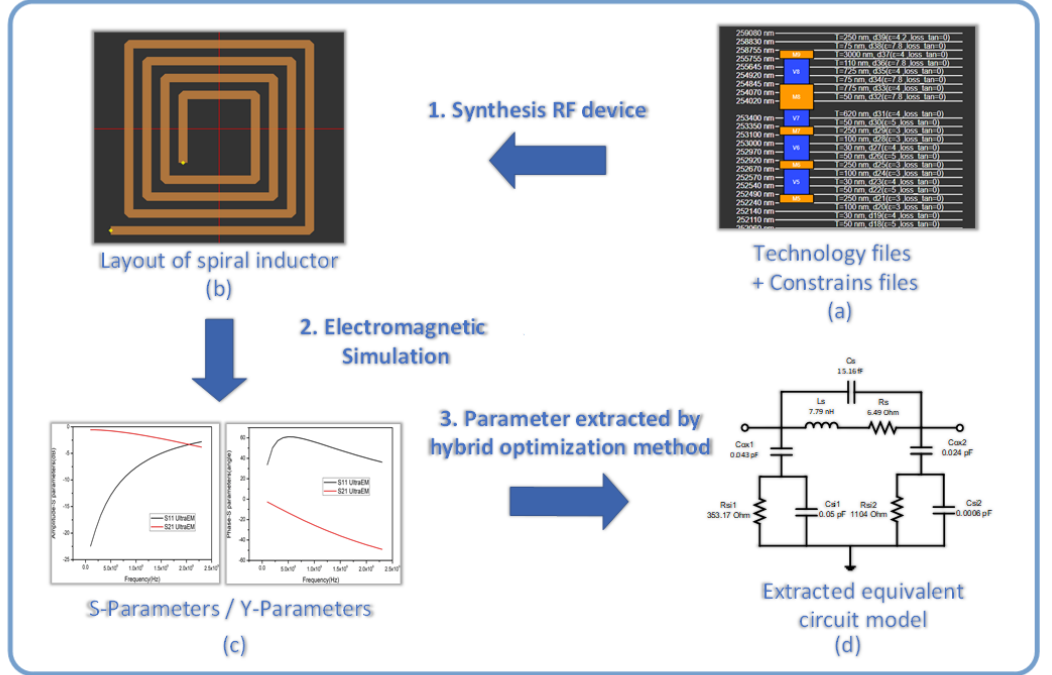
Figure 1. Parameter extraction application of hybrid optimization